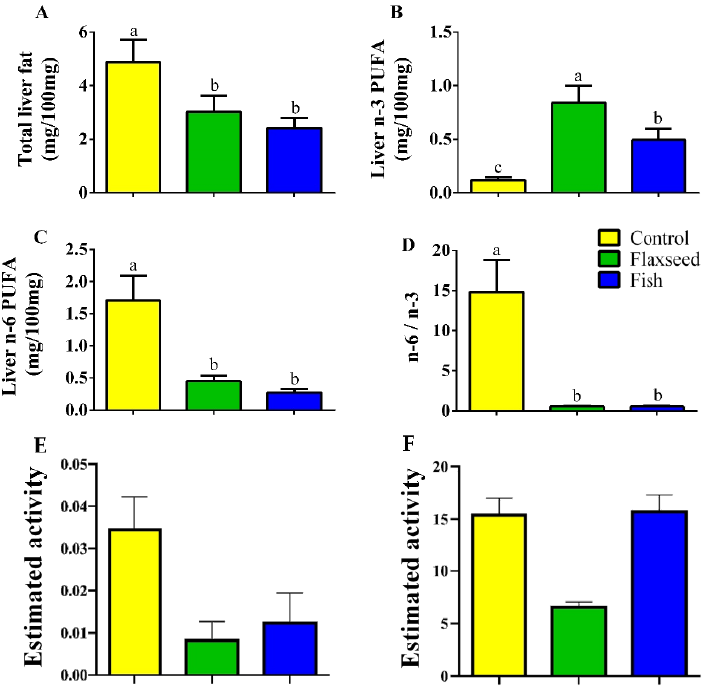
Figure 2. Hepatic FAs of 9-week-old mice. Lipids were extracted from liver samples and FA composition was analyzed by gas chromatography (GC). ( A ) Total hepatic fat levels (mg/100 mg liver). ( B ) Total hepatic n-3 PUFAs. ( C ) Total hepatic n-6 PUFAs. ( D ) Hepatic n-6 to n-3 ratio. ( E